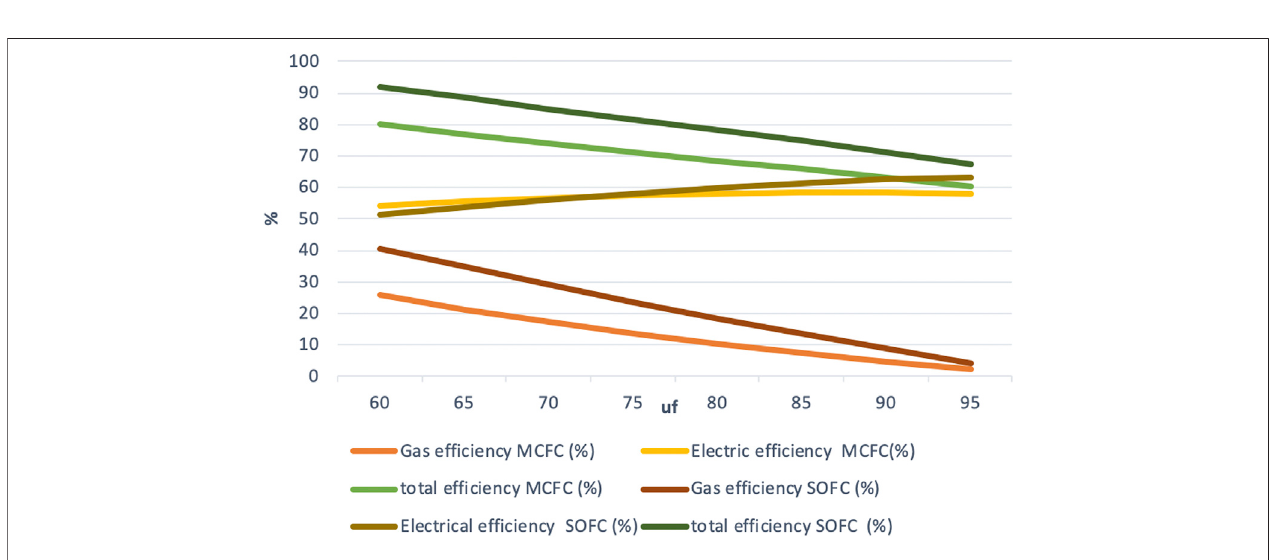
FIGURE 5 | Ef fi ciency vs. fuel utilization for constant current density